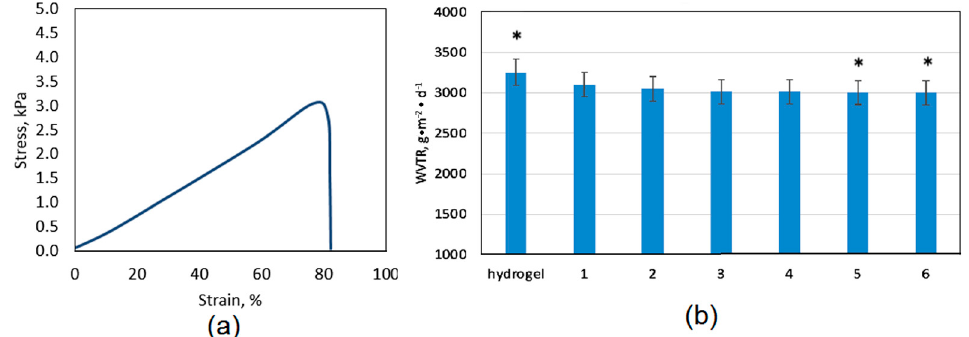
Figure 9. ( a ) tensile strength of the swollen hydrogel; and ( b ) water vapor permeability. (* p < 0.05).